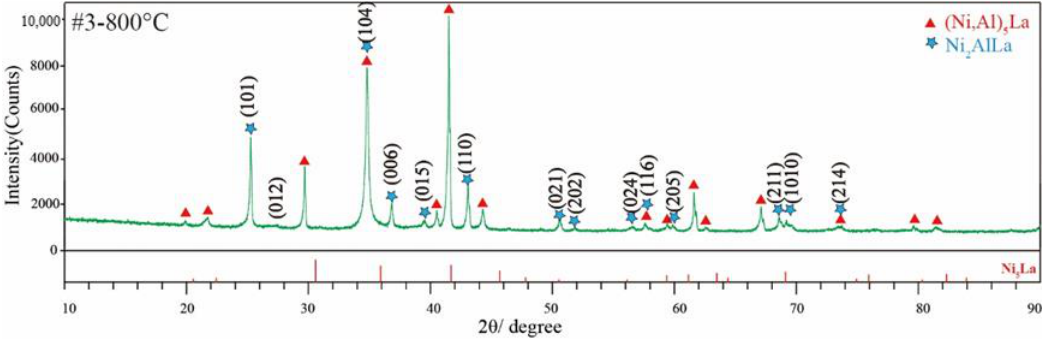
Figure 5. XRD pattern of #3 alloy annealed at 800 °C for 30 days.